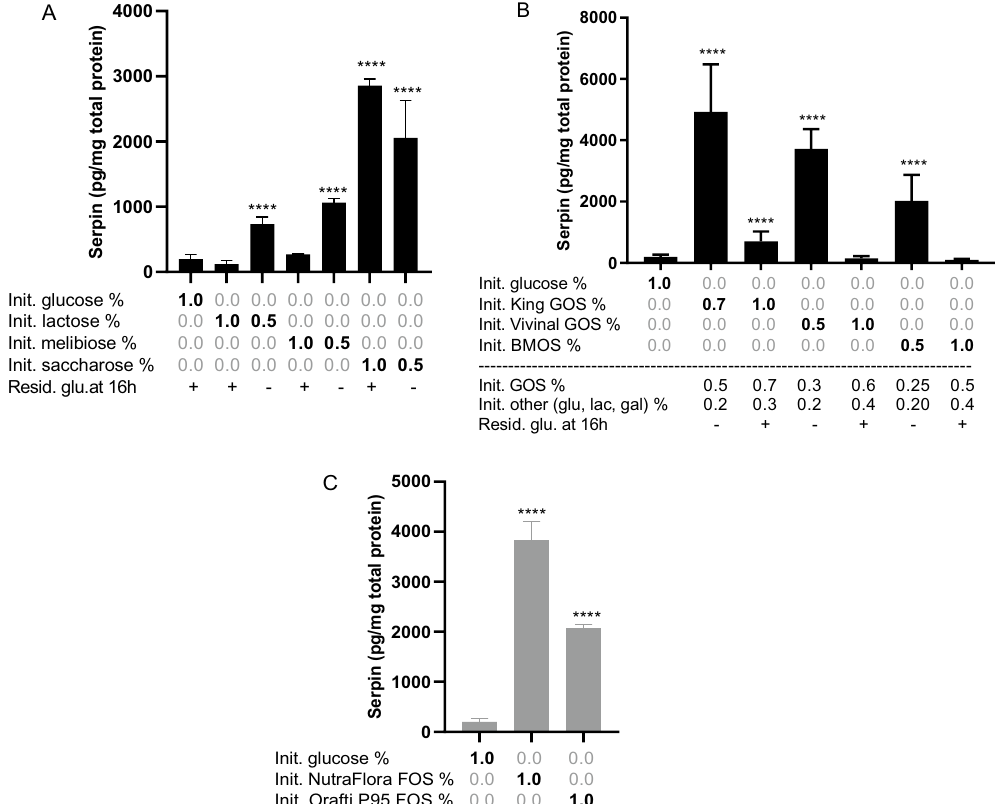
Figure 5. Serpin concentration in extracts of B. longum NCC 2705 grown to the stationary phase (16 h) on MRSc medium, supplemented with the di-saccharides galactose, melibiose and saccharose (panel A), different galacto-oligosaccharides (GOS) (panel B), or different fructo-oligosaccarides (FOS) (panel C). Bars represent means and standard deviations are depicted. Initial carbohydrate concentrations as well as the presence of residual glucose at harvesting are indicated ( A , B ). P -values represent statistical difference to the glucose control groups. **** p <